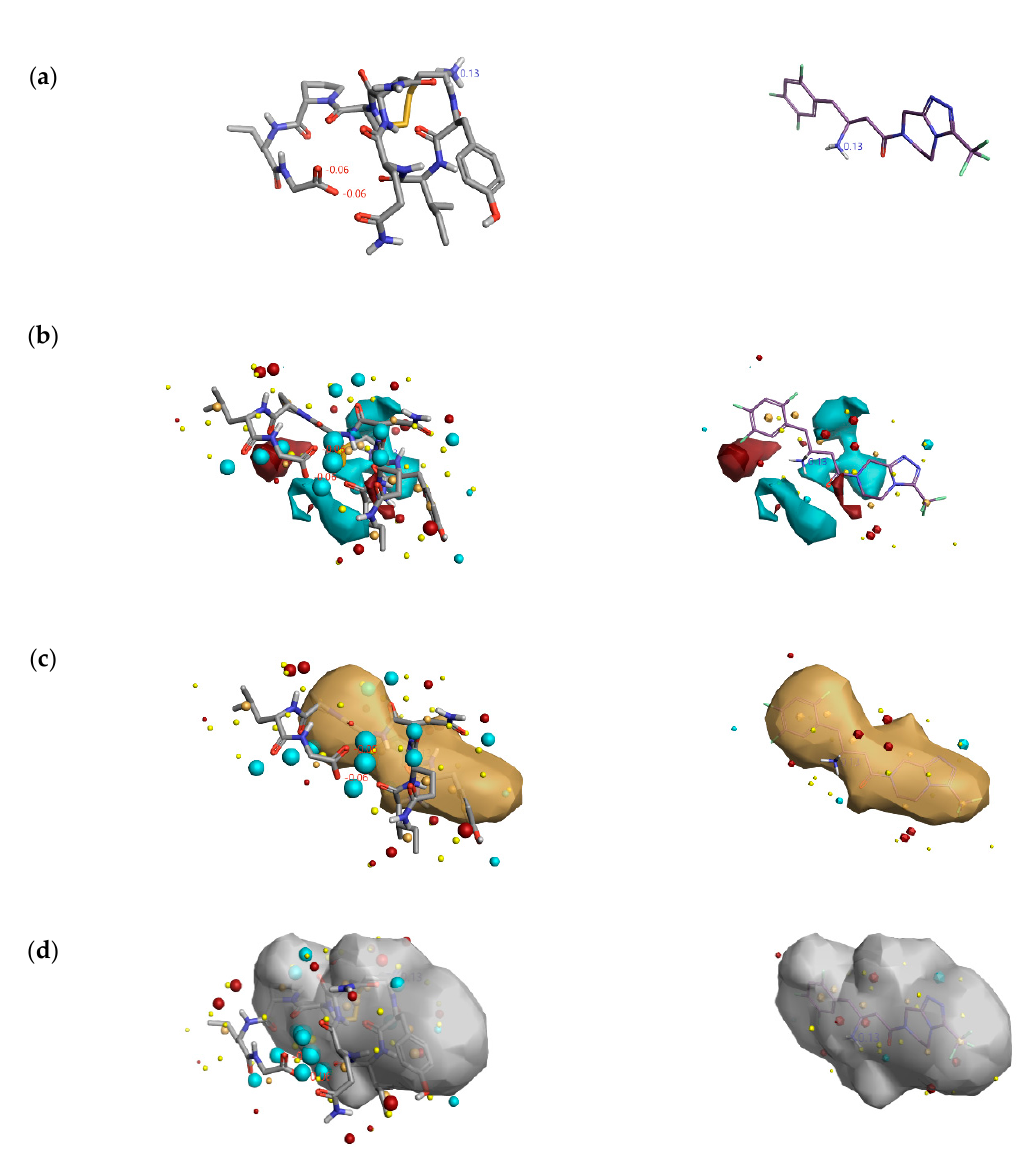
Figure 6. Comparison of features predicted by the activity atlas model on clinically used inhibitor and natural cyclic peptide oxytocin. The three-dimensional structure of oxytocin and sitagliptin ( a ); average activity summary of positive is shown in red color and negative electrostatics is shown in blue color ( b ); average shape of hydrophobics active ( c ); and average shape of actives ( d ) calculated using activity atlas model of DPP4 inhibitors. Forge visualization tool is utilized to understand the features.